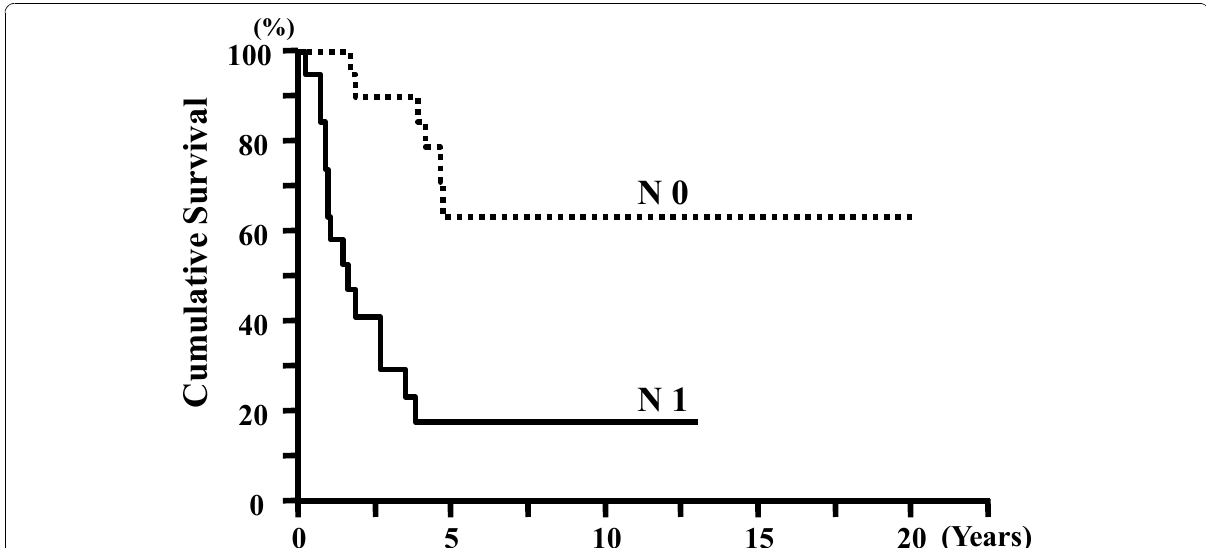
Figure 3 Cumulative survival of patients with lymph node metastasis (N) . Node-positive (N1) patients showed significantly poorer survival than node-negative (N0) patients (p <